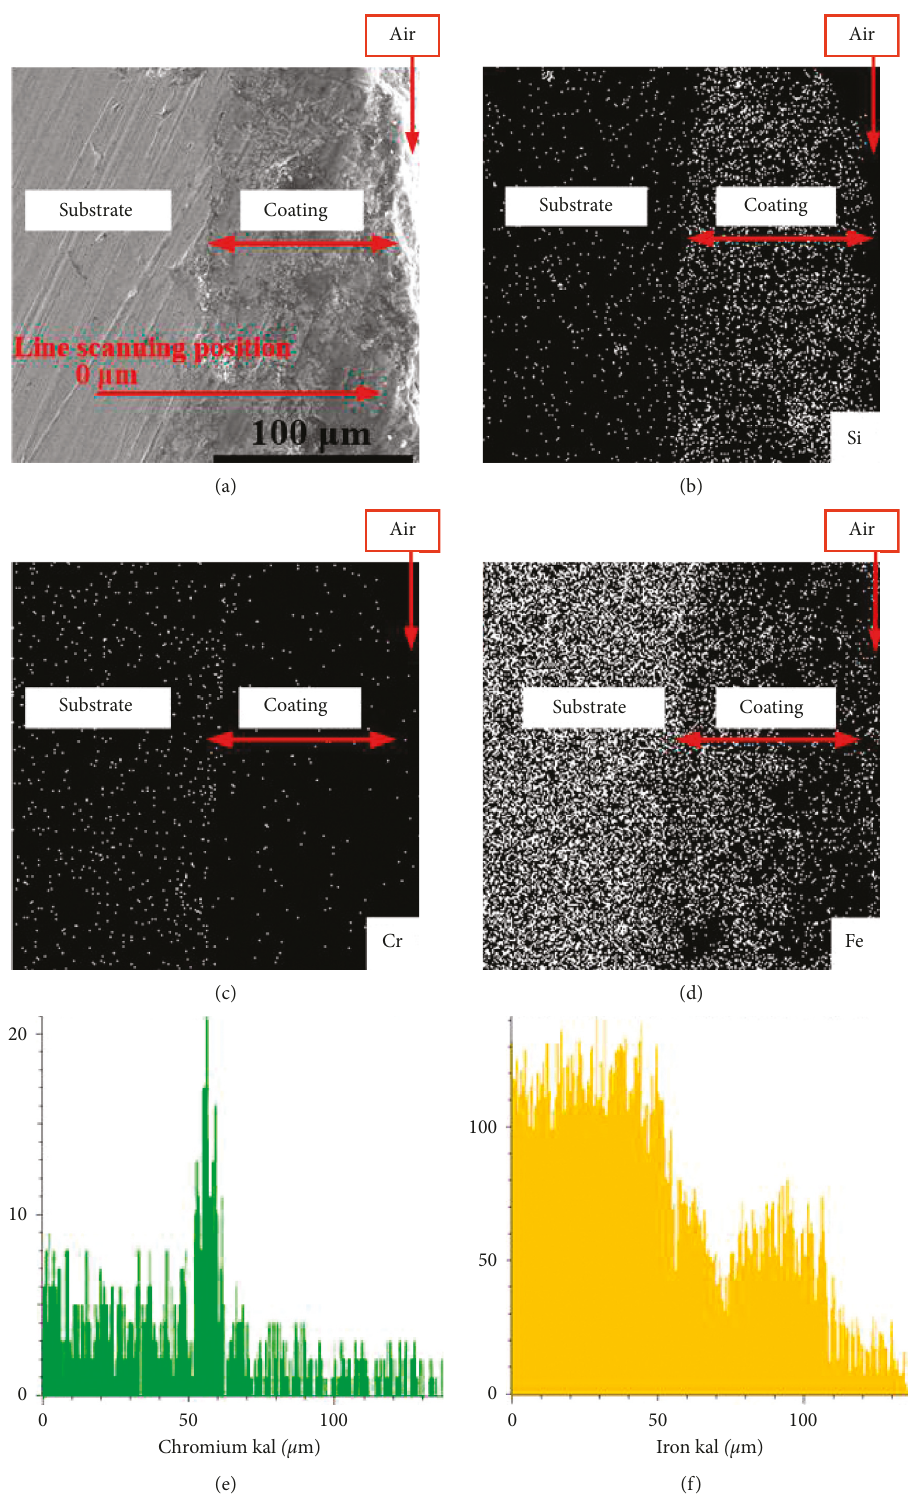
Figure 3: Element distribution on the cross section of the 20CrMnTi coated